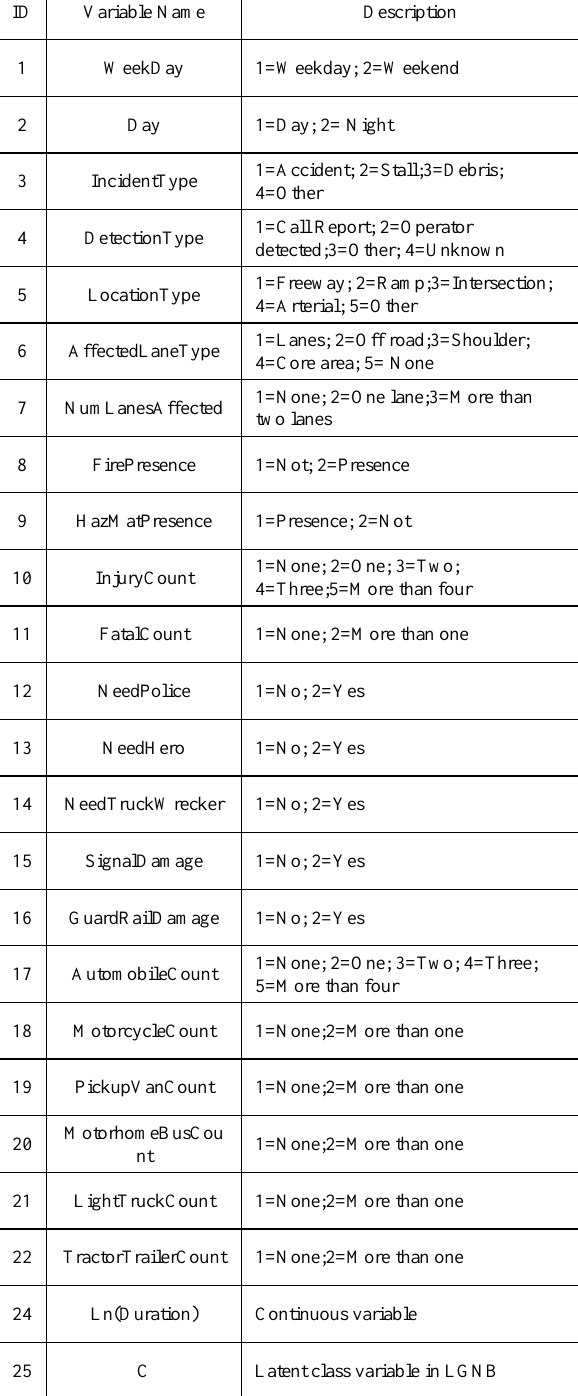
Table 2. Description of